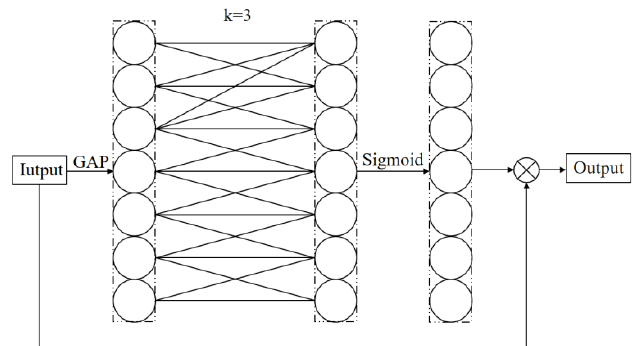
Figure 11. Structure of ECA module.